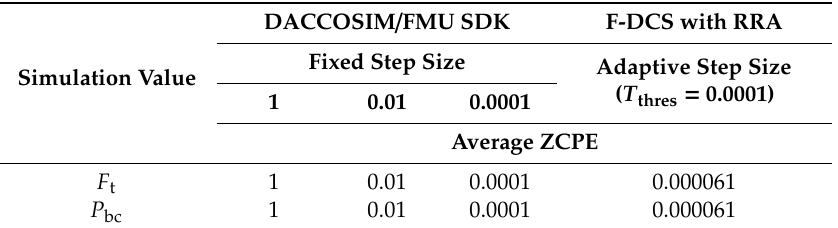
Table 3. Average zero crossing point error (ZCPE) of simulation